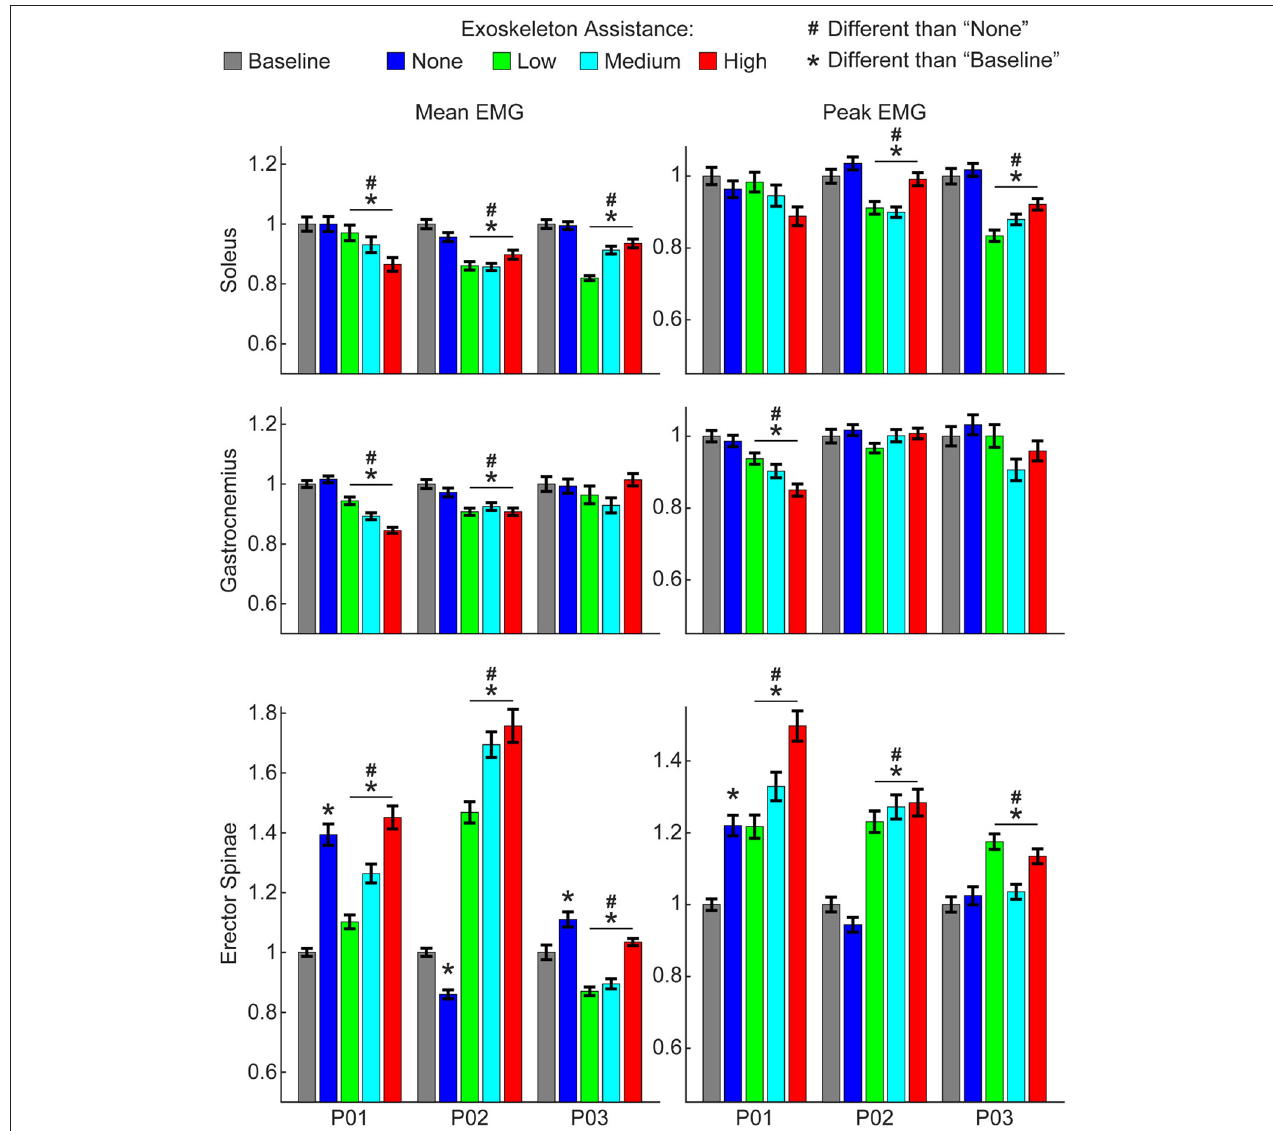
FIGURE 3 | Changes in EMG activity due to exoskeleton assistance. Changes in EMG activity were non-linear and unique to each muscle group and participant. Generally, wearing the exoskeleton in a passive state “none” condition did not alter EMG activity of lower-limb muscles, but did increase activity of the lower-back (erector spinae) muscles. Mean and peak EMG activity for lower-limb muscles were significantly less with active exoskeleton assistance relative to the baseline and relative to the passive exoskeleton. In contrast, mean and peak EMG activity for lower-back muscles were significantly greater with active exoskeleton assistance relative to the baseline and relative to the passive exoskeleton. Trends with increasing exoskeleton assistance were unique to each participant and muscle group. Additional muscle groups are shown in Supplementary Figure 1. Data show EMG activity averaged across each gait cycle for the right and left legs and normalized to the baseline